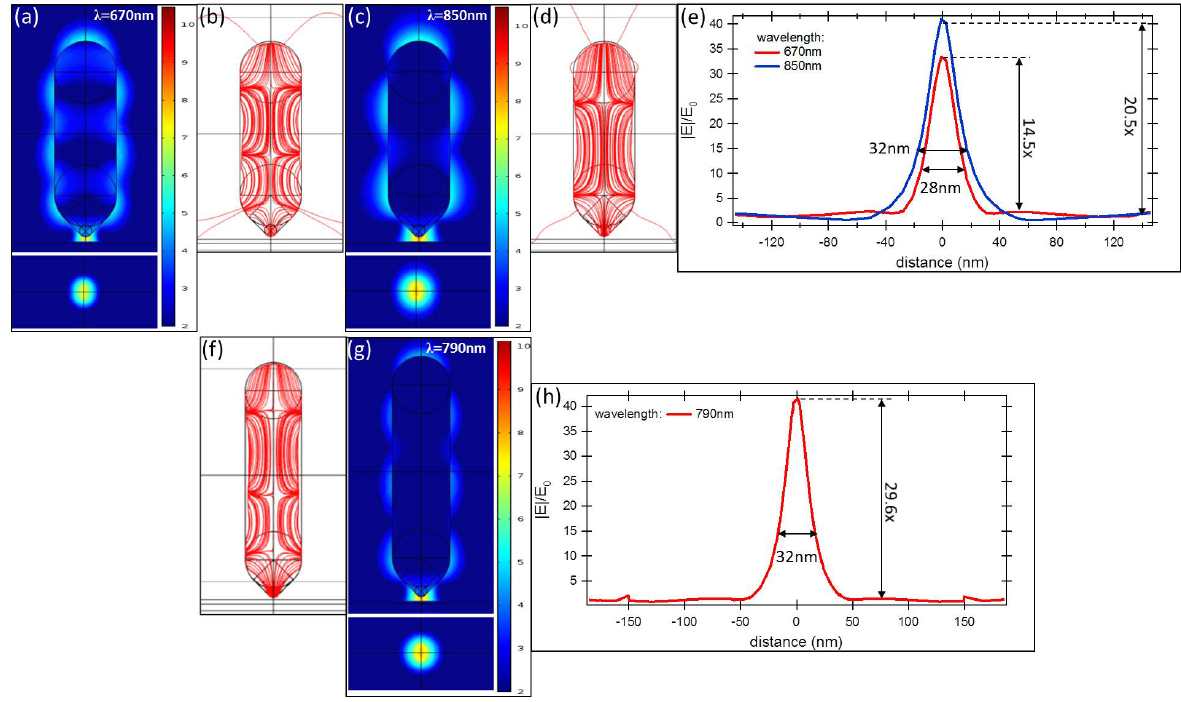
Figure 5: (a), (c), (g) Electric field profile (logarithmic scale) through a cross-section of the droplet transducer and (b), (d), (f) electric field lines of the (a), (b), (f), (g) octupole and (c), (d) hexapole modes excited at the droplet transducer for h = 200 nm (a-d) and h = 300nm (f, g). (e), (h) Electric field distribution along the width of a droplet transducer through the center at distance of a 7 nm from transducer and normalized to E 0 for h = 20 nm (e) and h = 300 nm (h).